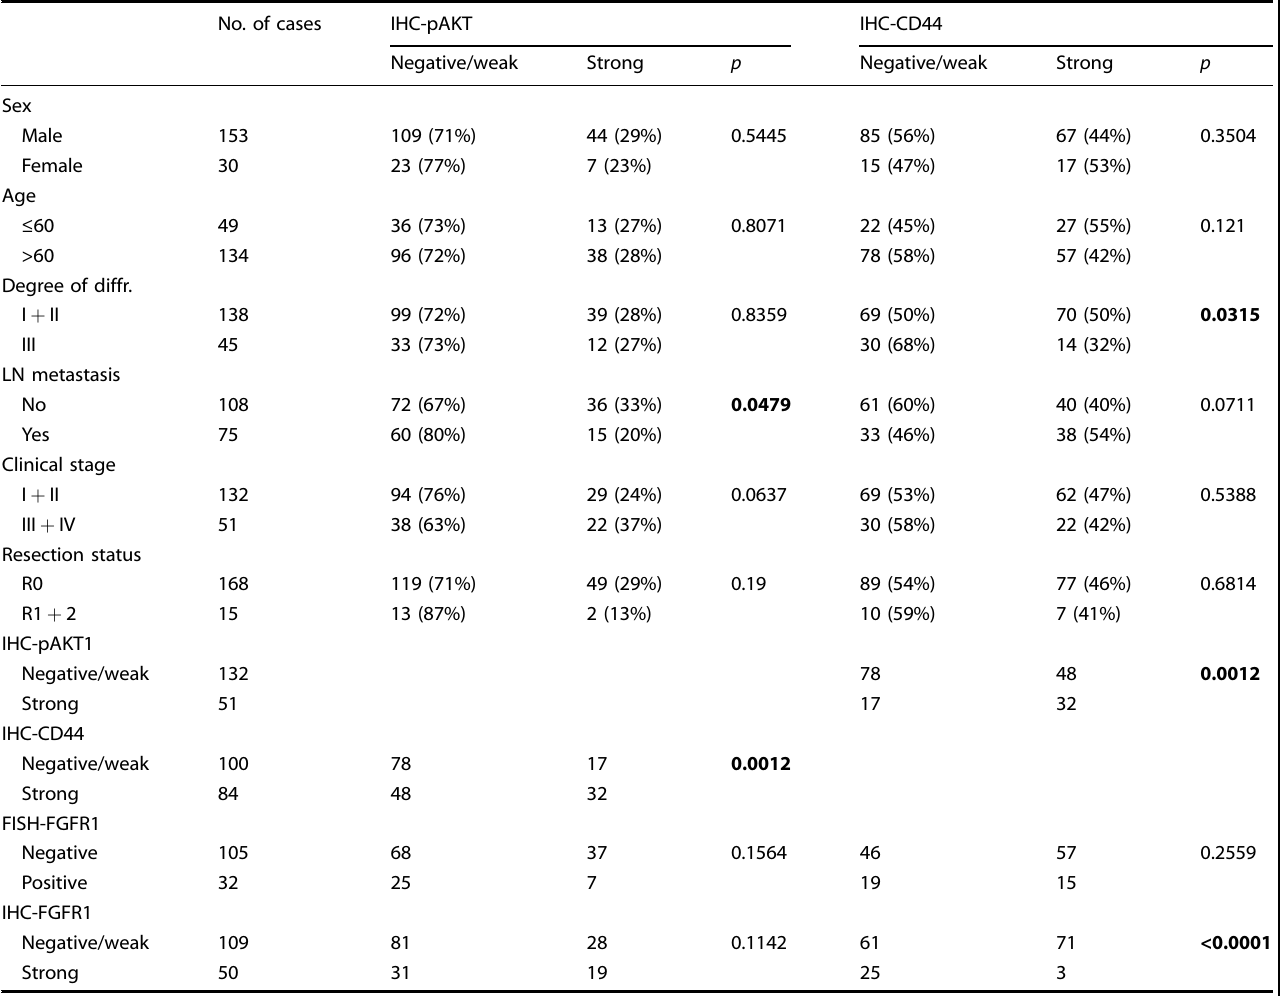
Table 1. Patients ’ characteristics and immunohistochemistry